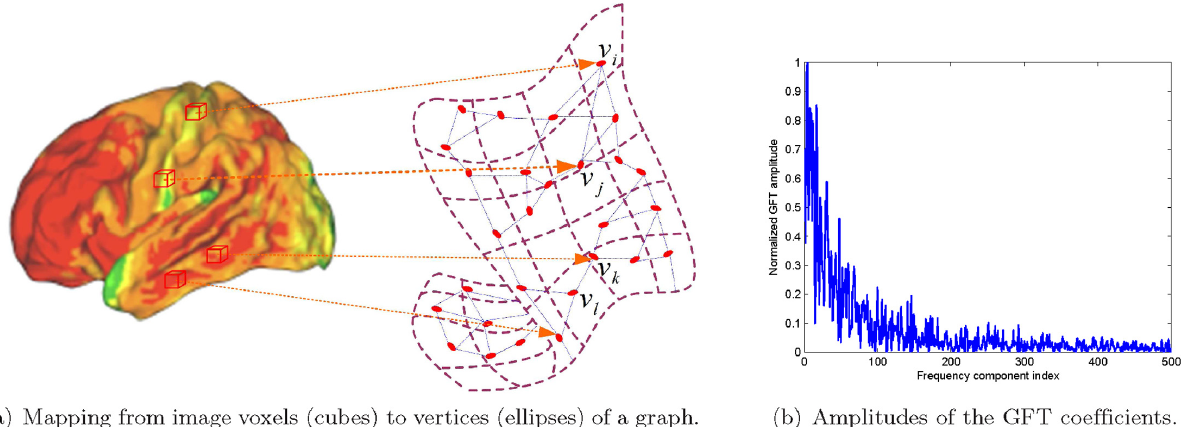
Fig 1. An example of smooth signal on graph. The left panel illustrates the mapping a 3D-PET image to a weighted graph that describes the affinity between every pair of voxels, exemplified by the 3D brain image in [6]. The amplitudes of the first few GFT coefficients of the image are displayed in the right panel, where the amplitudes have been divided by the the maximum value among